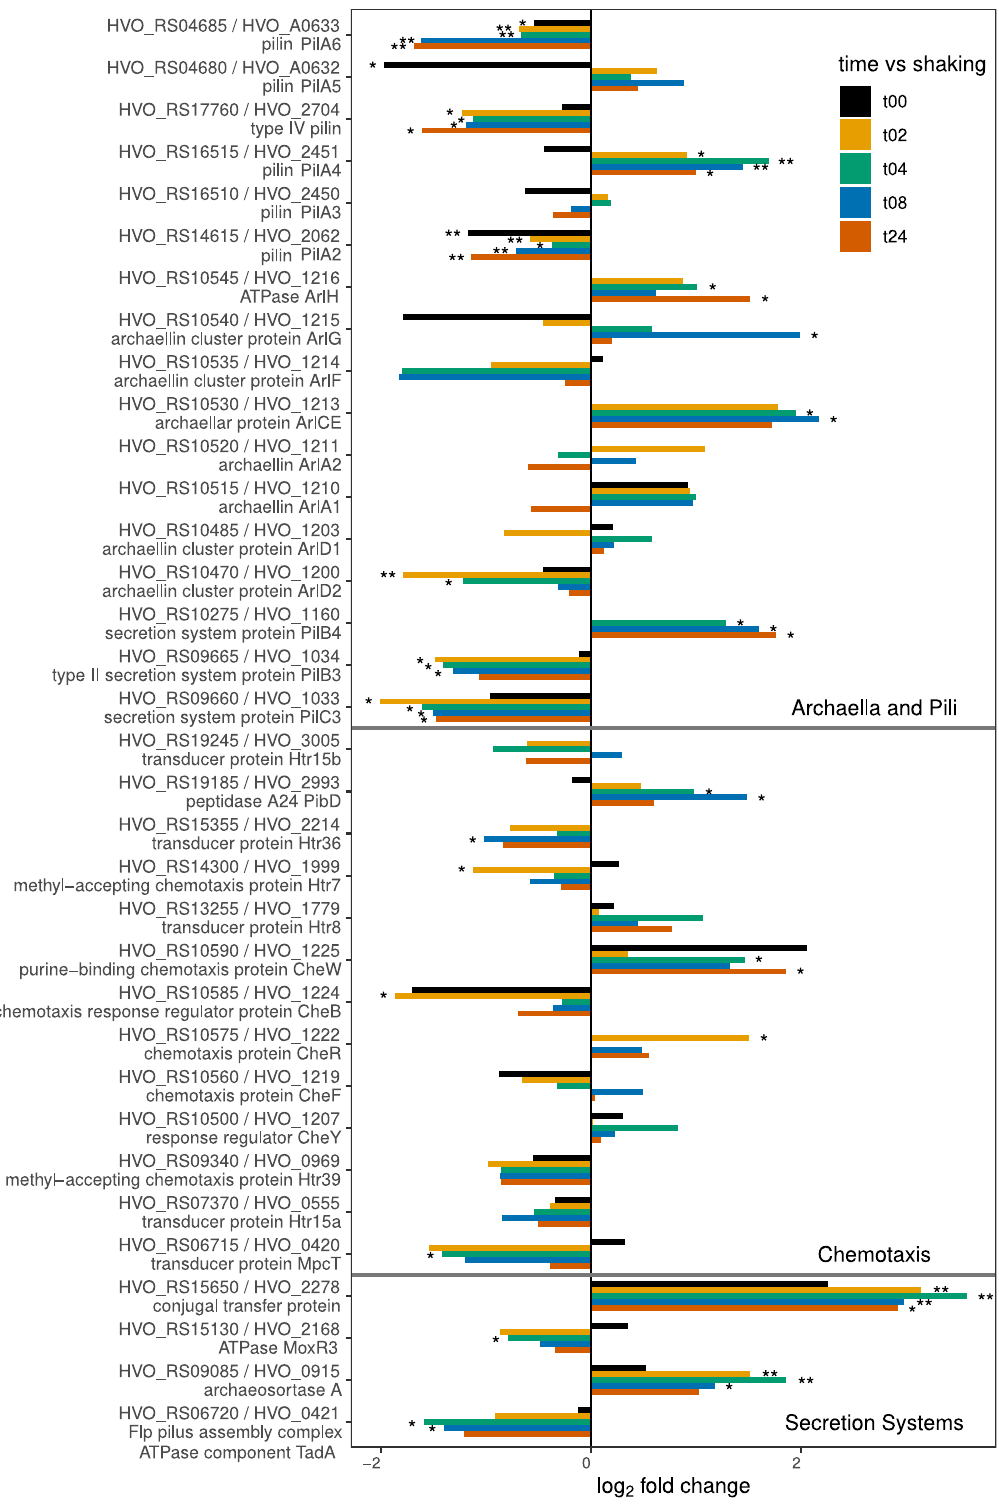
Figure 3. Bar plot depiction of differential expression compared to planktonic state for genes involved in community development and biofilm formation; gene id on the y-axis and log 2 fold change on the x-axis, * p value < 0.05 and ** p value <